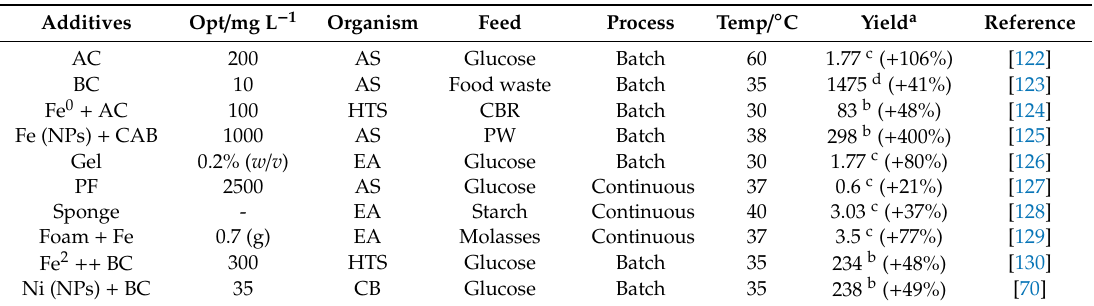
Table 5. Comparisons of bio-hydrogen production with synergistic e ff ects of adding biomass immobilization and